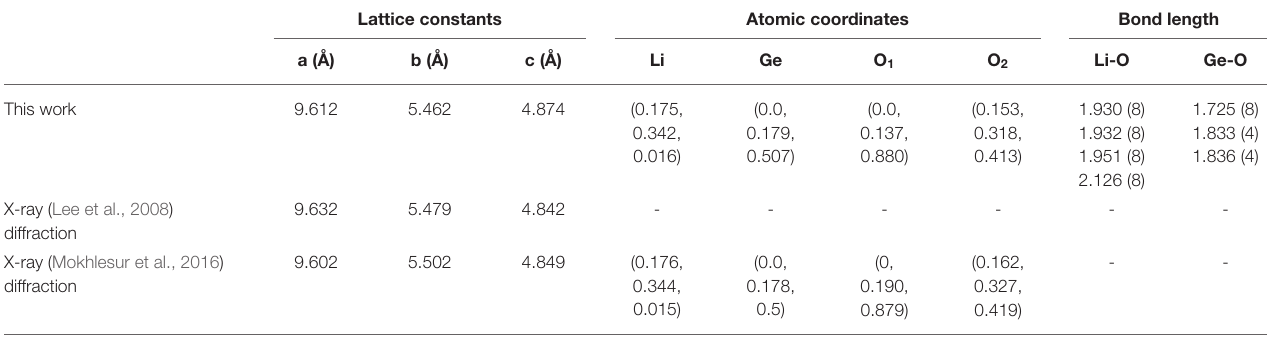
TABLE 1 | Structure parameter of 3D ternary Li 2 GeO 3 compound. Lattice constants Atomic coordinates Bond